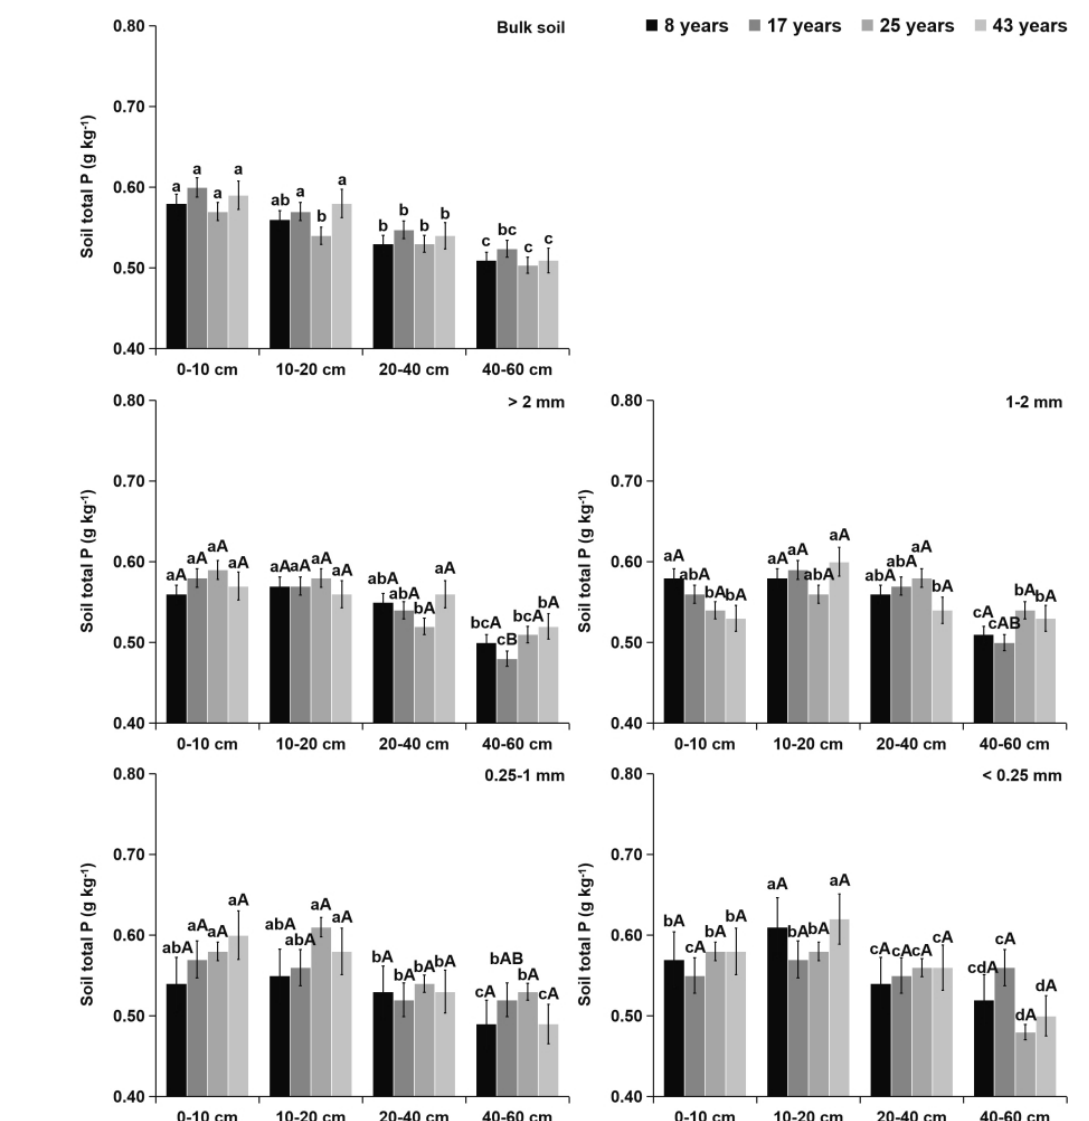
Figure 4. Effects of soil depth and tea plantation age on the total P content in bulk soil and different-sized aggregates. Data represent the mean of five replicates, and error bars represent the standard deviations. Means with the same lowercase letter are not significantly different ( p > 0 . 05) among different soil depths and tea plantation ages. Means with the same capital letter are not significantly different ( p > 0 . 05) among different-sized